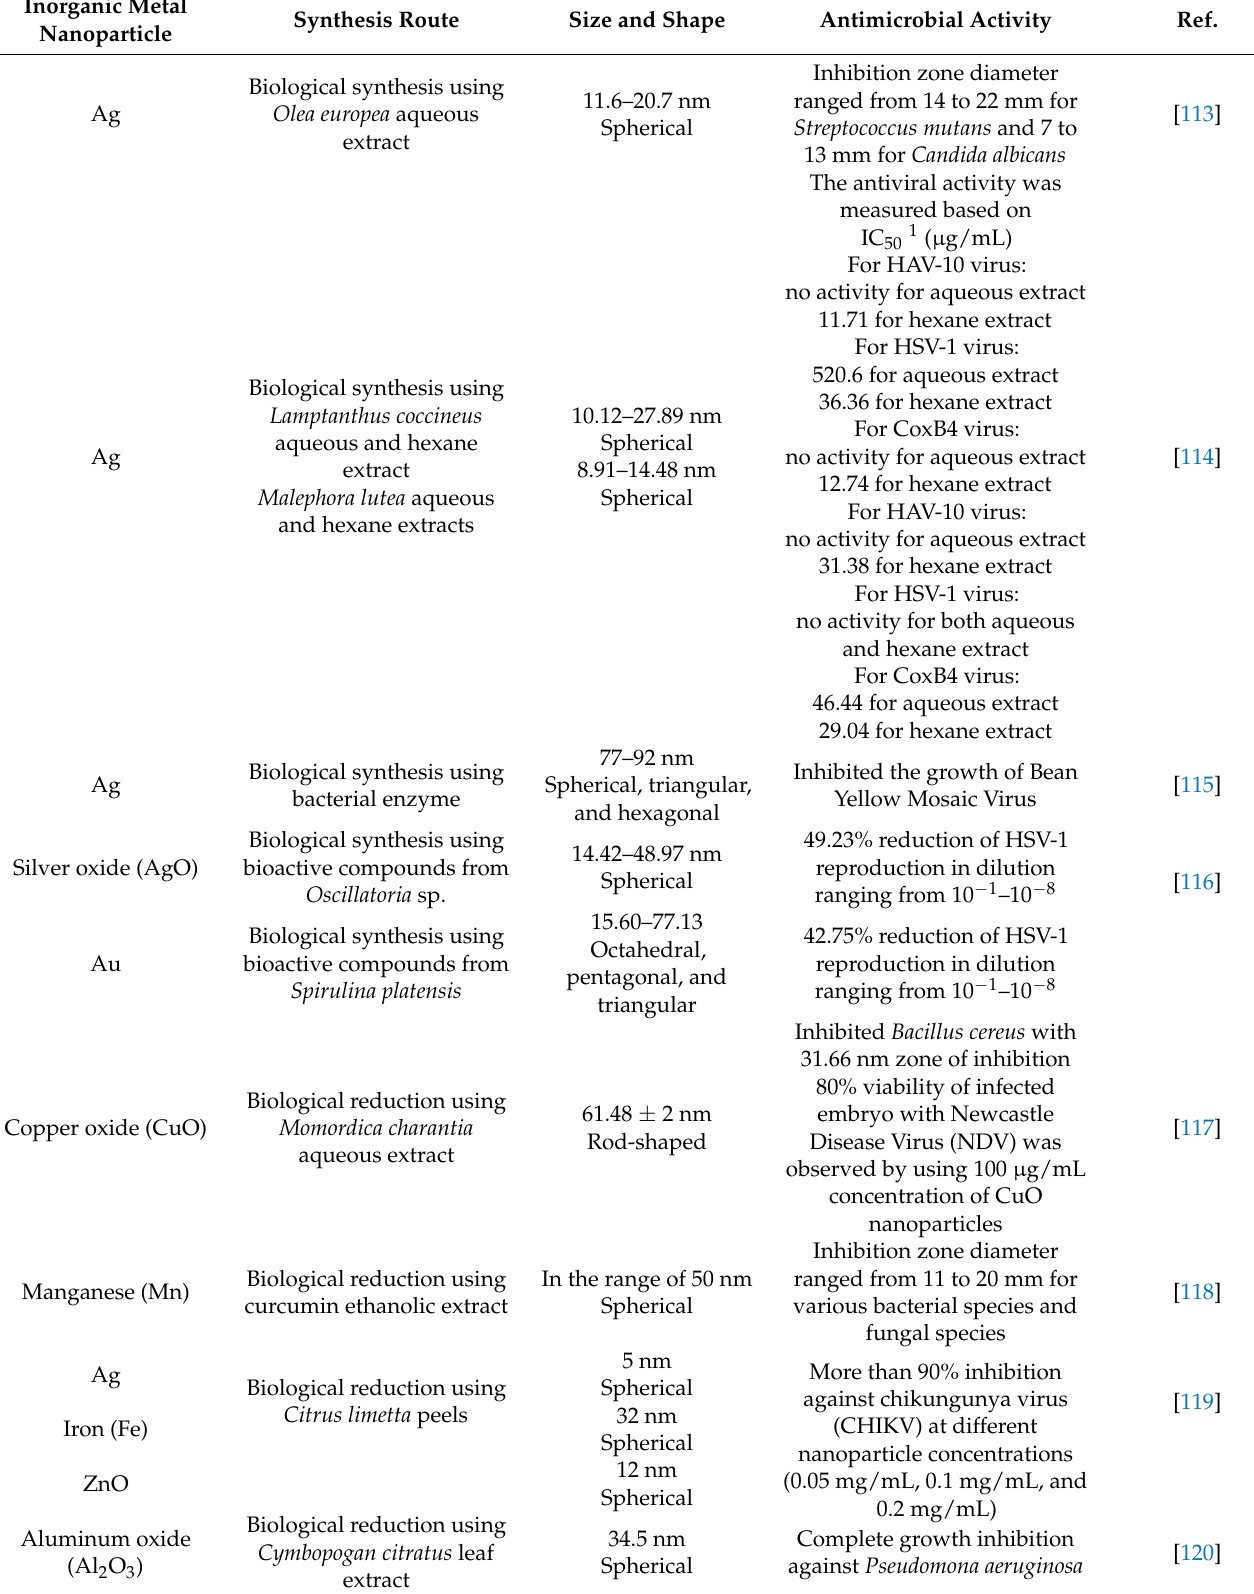
Table 2. Inorganic metal nanoparticles: sources, physical characteristics, and antimicrobial activity. Inorganic Metal